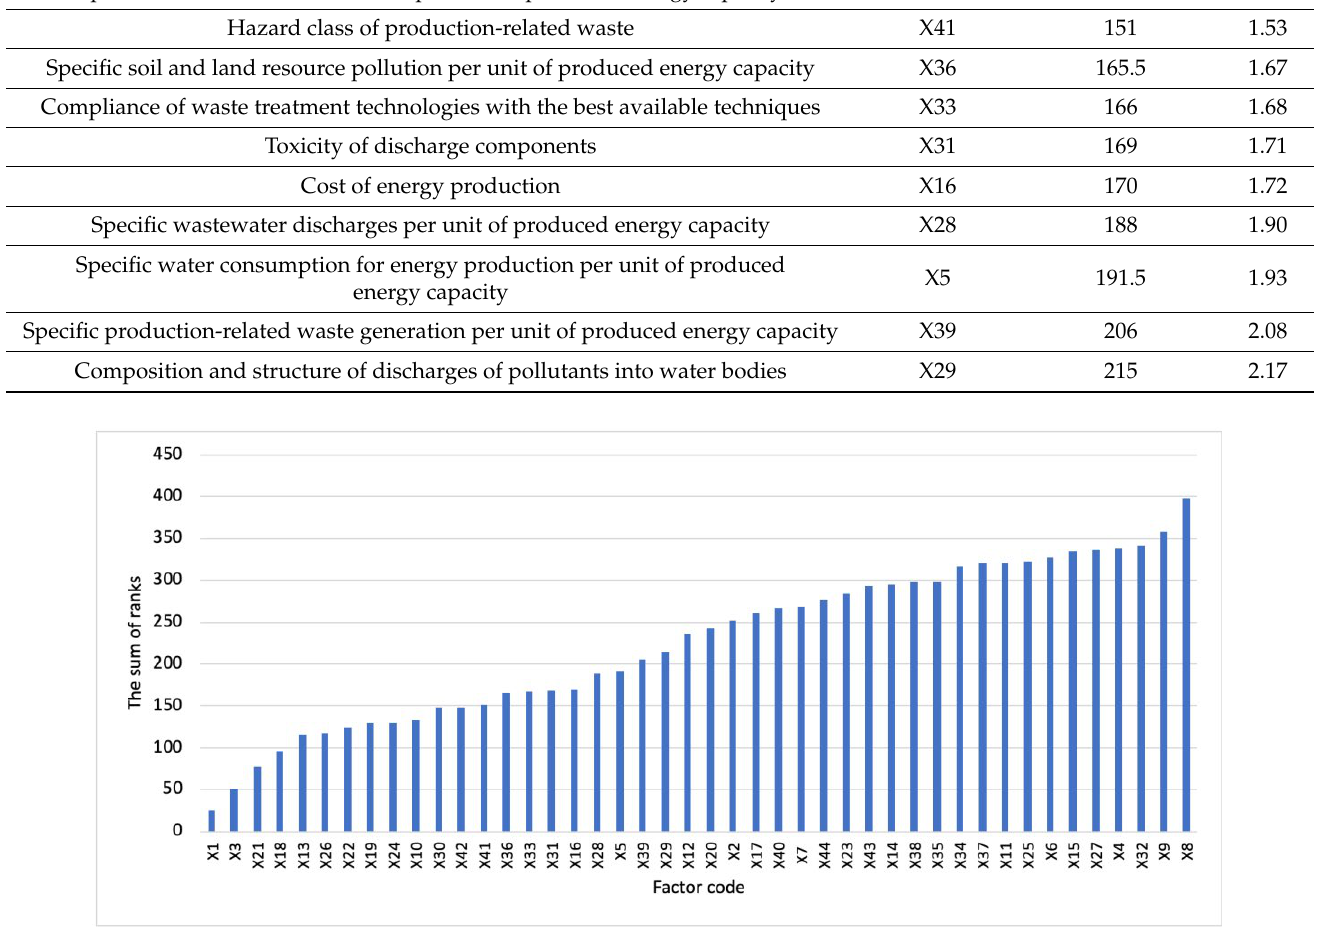
Figure 3. The diagram of a priori ranking of factors.